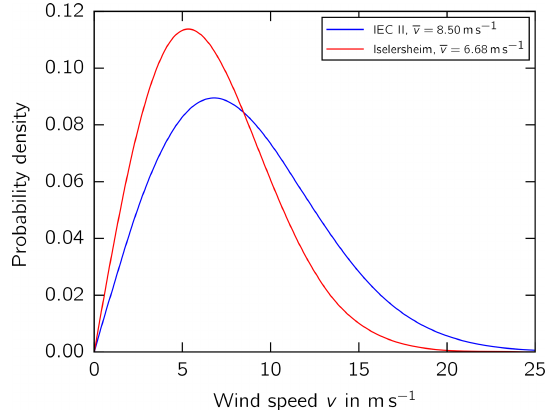
Figure 3. Probability density of wind speed of design condition and at actual site. Table 1. Design parameters of 1.5MW turbine. Parameter Symbol Value